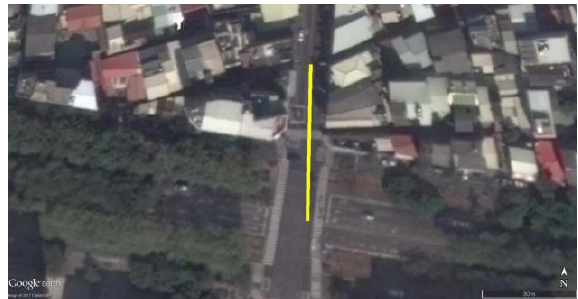
Figure 3. The trajectory of testing data (from Google Earth) Yellow line represents the trajectory of MMS.